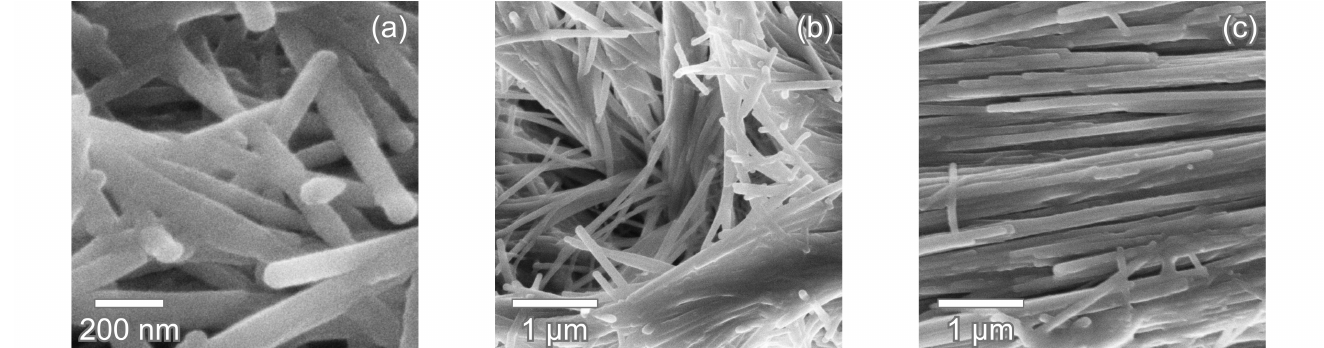
Figure 8. Fluorapatite crystallites in C. taurus tooth. ( a ) Individual crystallites at the polished sectioning plane. ( b ) Crystal- lites curve and change orientation in the TBE while remaining parallel to their neighbors (transversal section). ( c ) Within a bundle in the inner enameloid, crystallites are in close contact with each other and aligned along their long axis (transver- sal